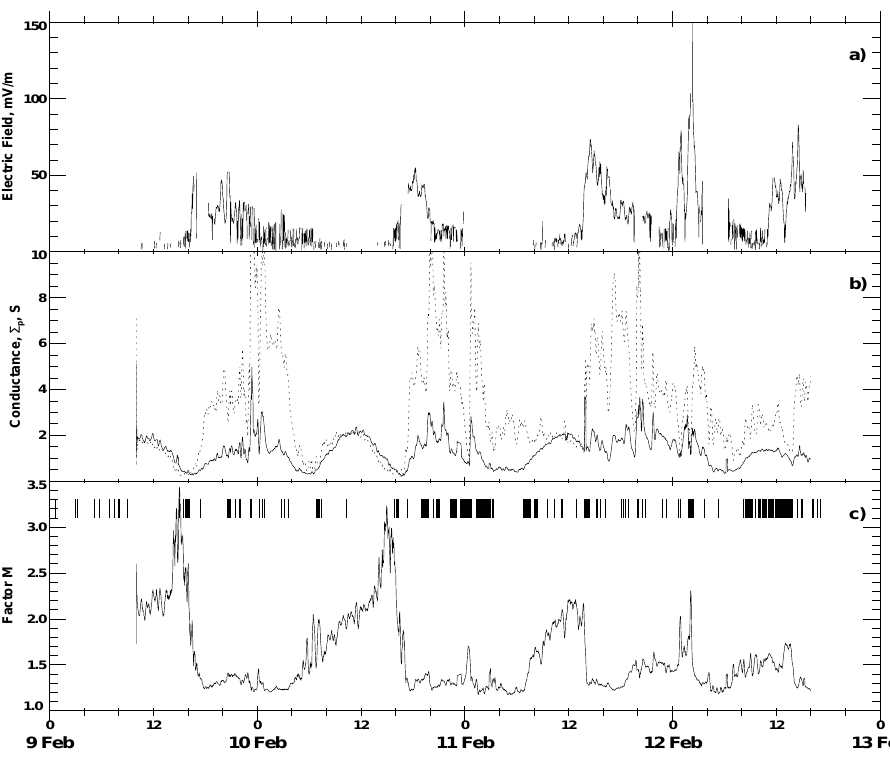
Fig. 9. Temporal variations of (a) the electric field, (b) the height-integrated Pedersen conductances in the F- and E-regions (solid line and dots, respectively), (c) the parameter M = 1 + 6 F p /6 E p influencing the growth rate of the F-region gradient-drift instability in the presence of conducting E-region and HF echo occurrence over the EISCAT spot (vertical